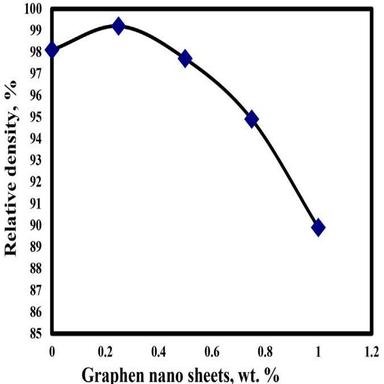
The relative density of Cu/WC-TiC-Co/GNs nano composites versus the graphene percent.